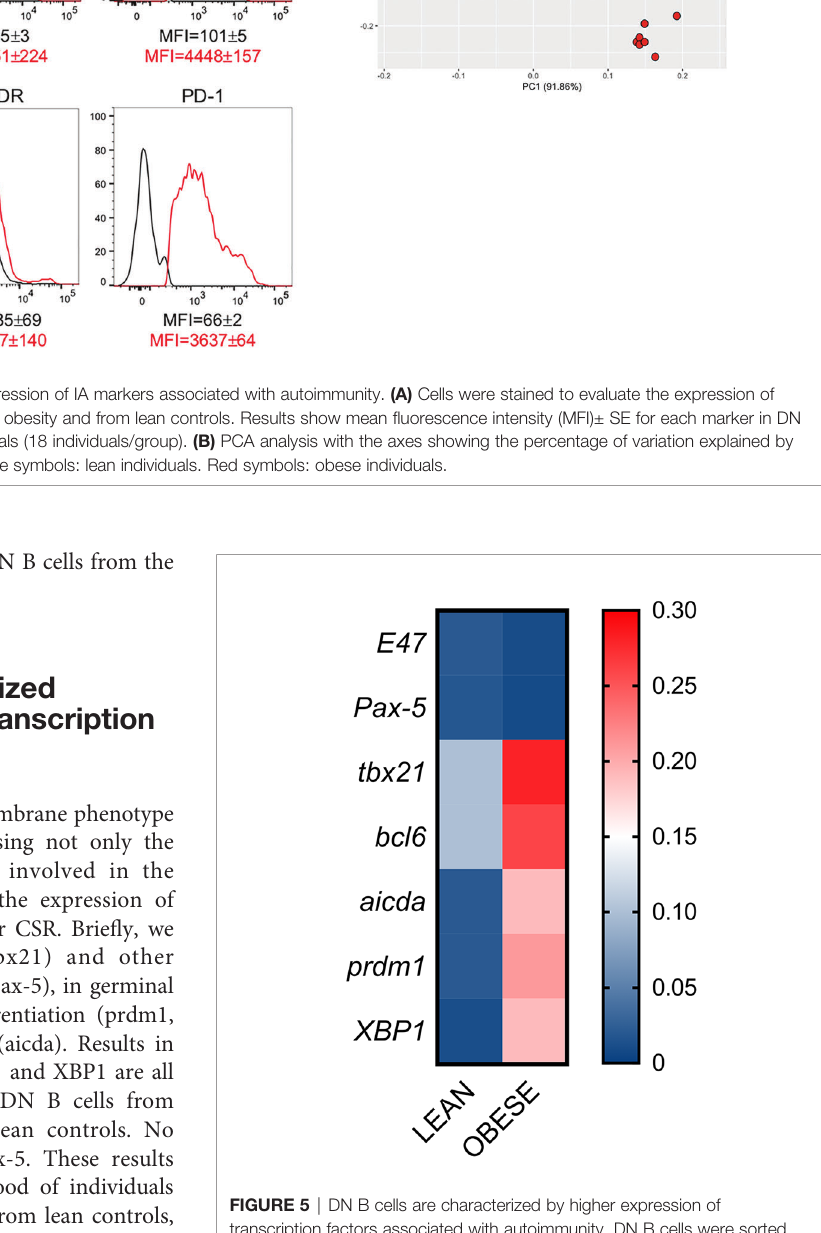
FIGURE 5 | DN B cells are characterized by higher expression of transcription factors associated with autoimmunity. DN B cells were sorted from the peripheral blood of individuals with obesity and of lean controls and left unstimulated. Total RNA was extracted to evaluate by qPCR the expression of transcription factors. Heatmap shows qPCR values (2 - DD Ct ) of several transcription factors, normalized to GAPDH. Results show average qPCR values from 18